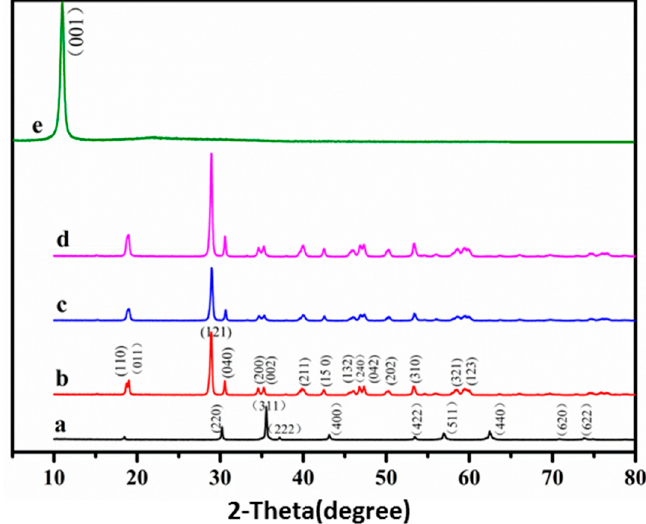
Figure 1. XRD patterns of ( a ) Mn 1 − x Zn x Fe 2 O 4 ; ( b ) BiVO 4 ; ( c ) BiVO 4 /Mn 1 − x Zn x Fe 2 O 4 ; ( d ) BiVO 4 /Mn 1 − x Zn x Fe 2 O 4 /RGO (reduced graphene oxide); ( e ) GO (graphene oxide).